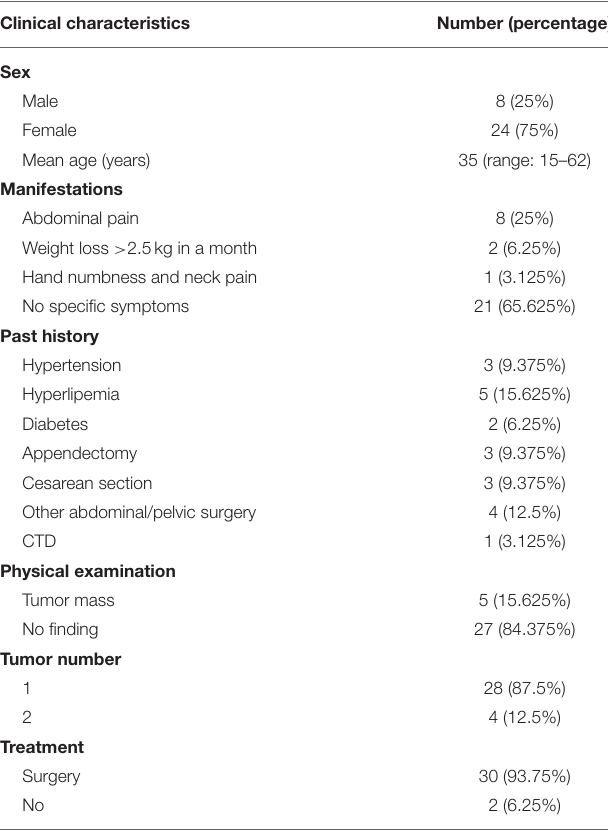
TABLE 3 | Radiological findings of 32 retroperitoneal GN